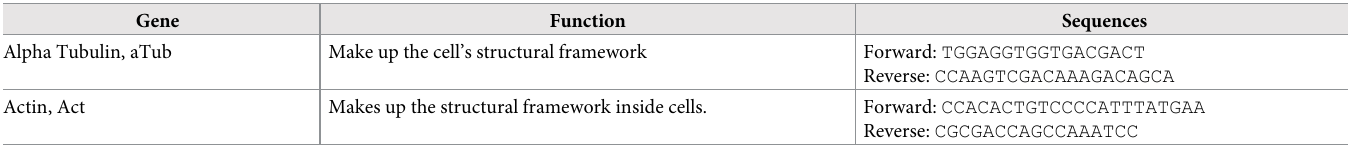
Table 2. Genes and primers used in the present study for Moina micrura [50]. Gene Function Sequences Alpha Tubulin, aTub Make up the cell’s structural